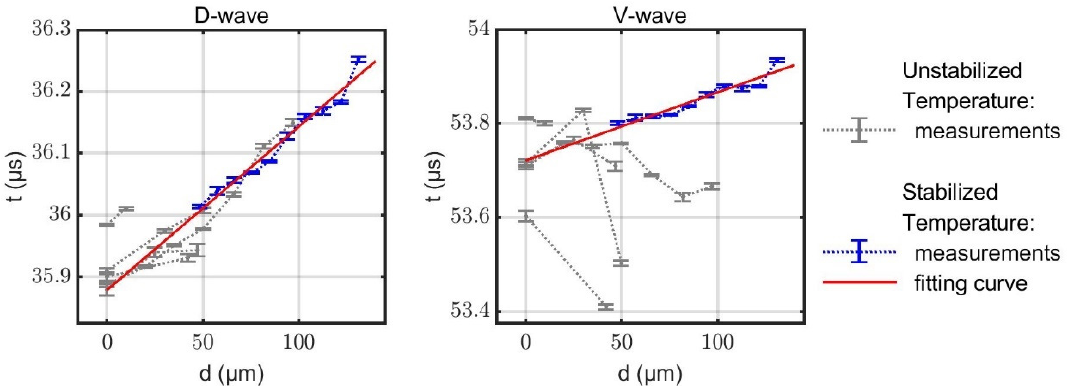
corresponding fitting curves are printed in red.